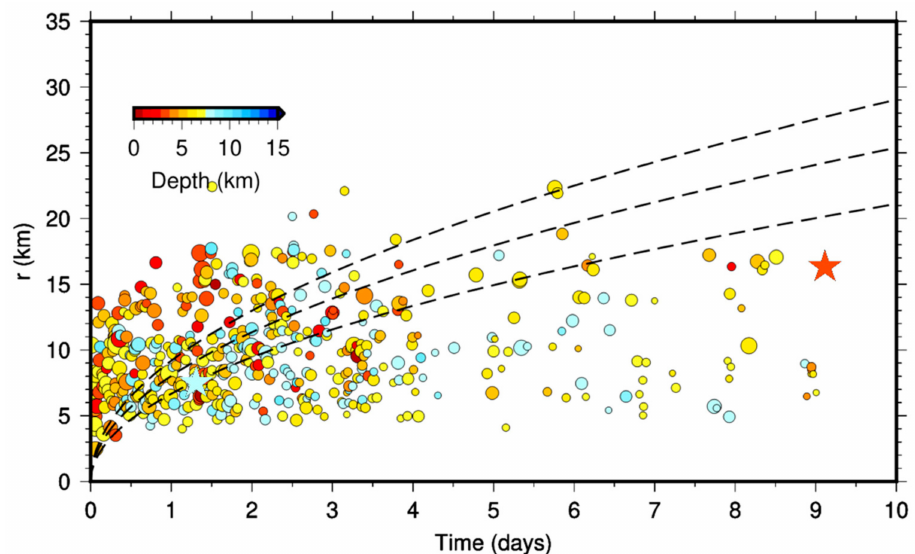
Figure 8. r-t plot for the relocated TSS seismic sequence. Only earthquakes with magnitude larger than the minimum magnitude of completeness (Mc 1.6) were considered. The dashed lines correspond to the triggering front evaluated by using the inferred diffusivity value 60 ± 37 m 2 /s and plus/minus one standard deviation. Symbols dimension is proportional to the event magnitude and color coded according to the depth. The two stars indicate the Mw 6.3 (light blue) and Mw 5.6 (orange),